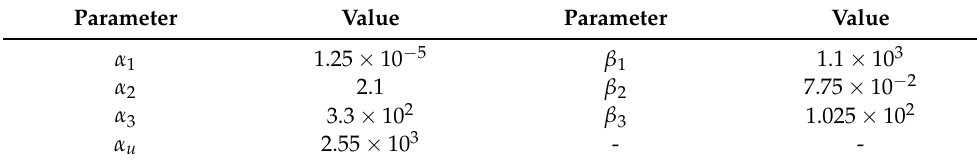
Table 4. Nominal values of tuning parameters based on Theorem 1.